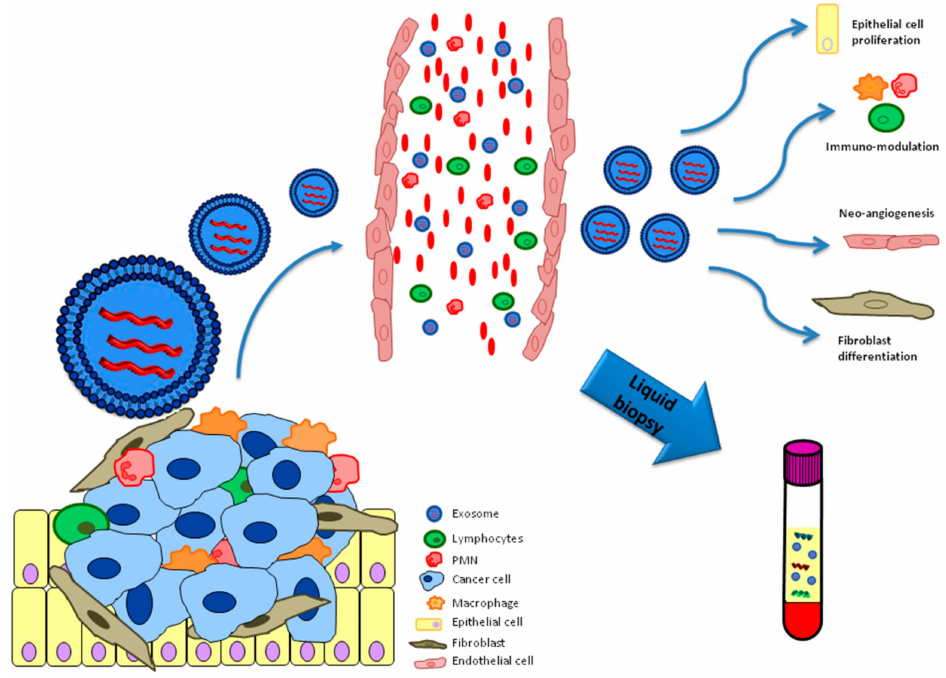
Figure 1. Functional role of exosomes released by the lung cancer microenvironment.